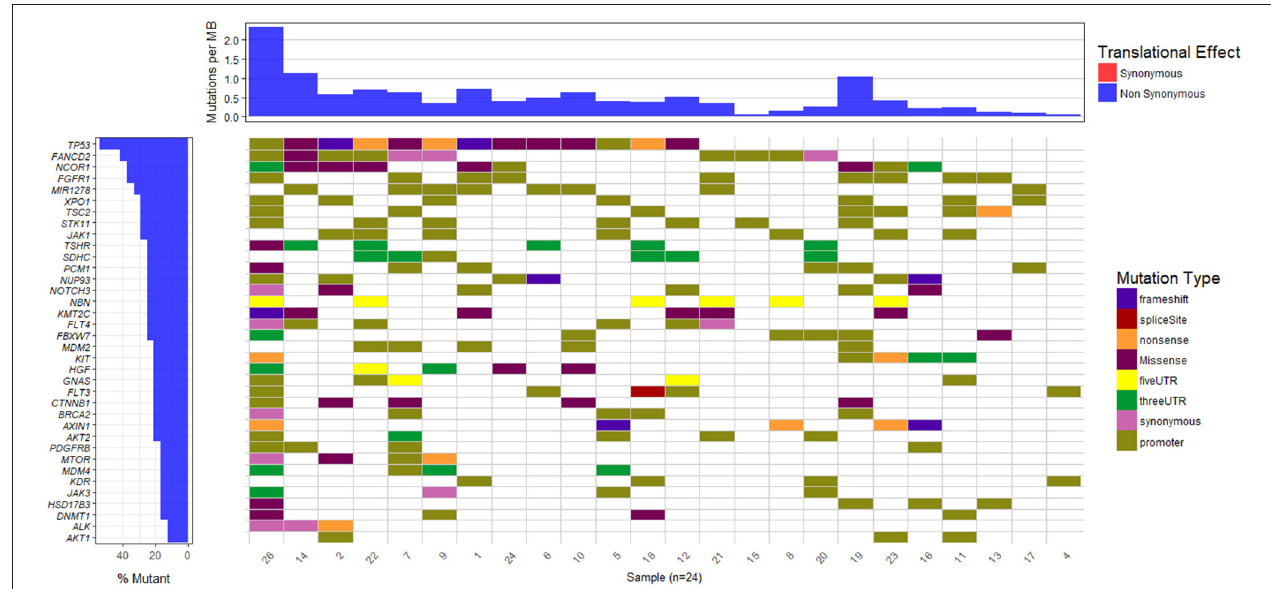
FIGURE 5 | Mutational landscape of somatic sequence variants identified in 24 HCC patient samples (intronic and intergenic variants excluded). Each column corresponds to each patient sample and each row represents a gene.